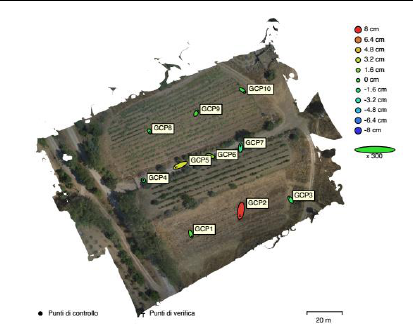
Figure 7. r.m.s. GCPs – 50 m flight